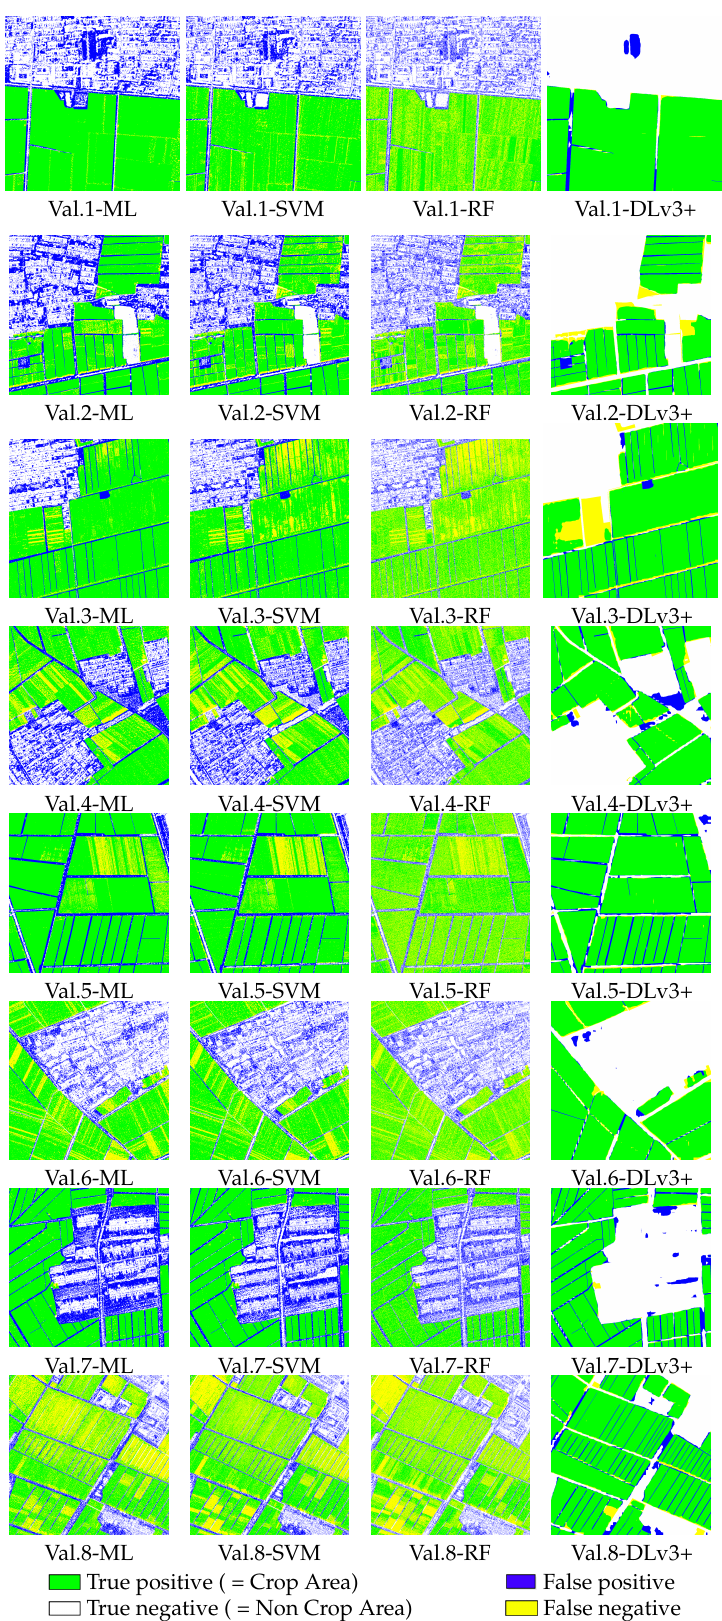
Figure 7. Classification maps for Maximum Likelihood (ML), Support Vector Machine (SVM), RF (Random Forest) and DeepLabv3+ (DLv3+) on eight validation (Val) slices.